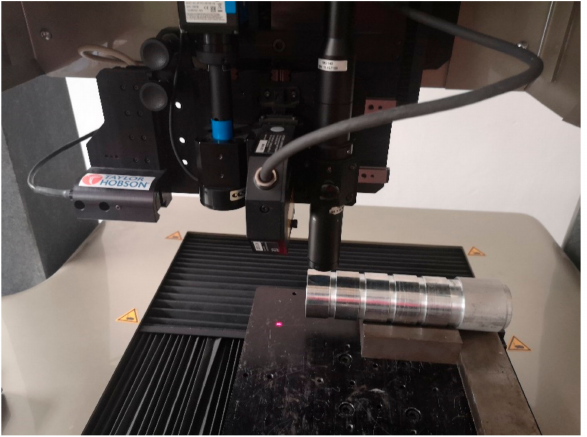
Figure 2. Working area of the Altisurf 520 measuring machine with CL2 confocal chromatic